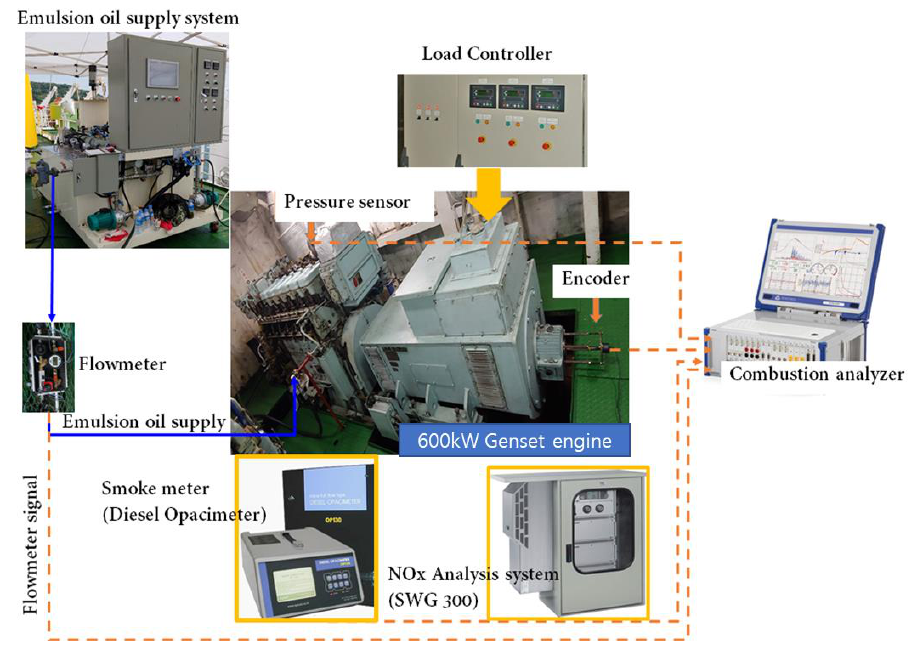
Figure 1. Schematic for a four-stroke marine engine, the data was from Table 1. Specifications for the test engine.